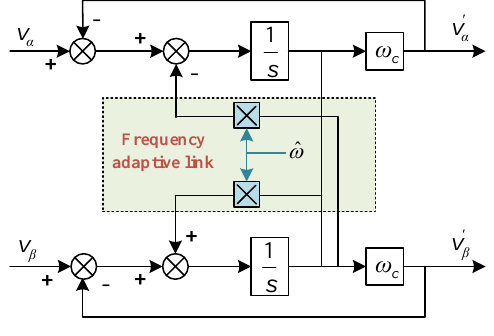
Figure 6. Control diagram of CCF.